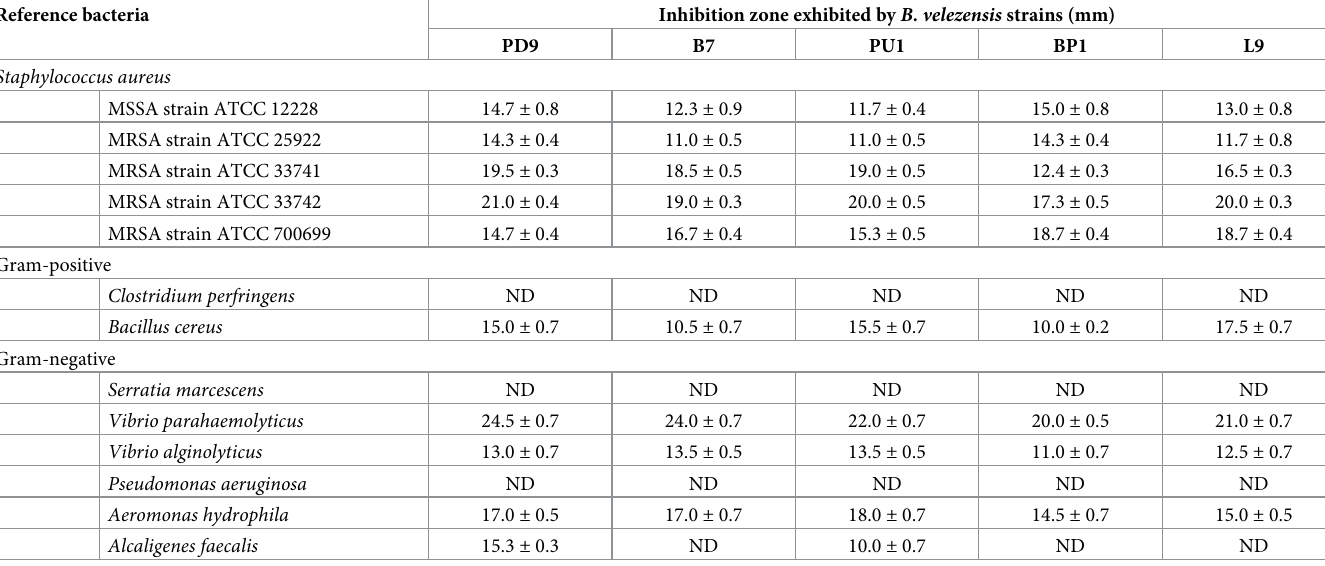
The B . velezensis strains CFS (served as crude antimicrobial compounds) were used for agar well diffusion assay. Reported values are mean ± standard deviation, “ND” = non-detectable and CFS = cell-free